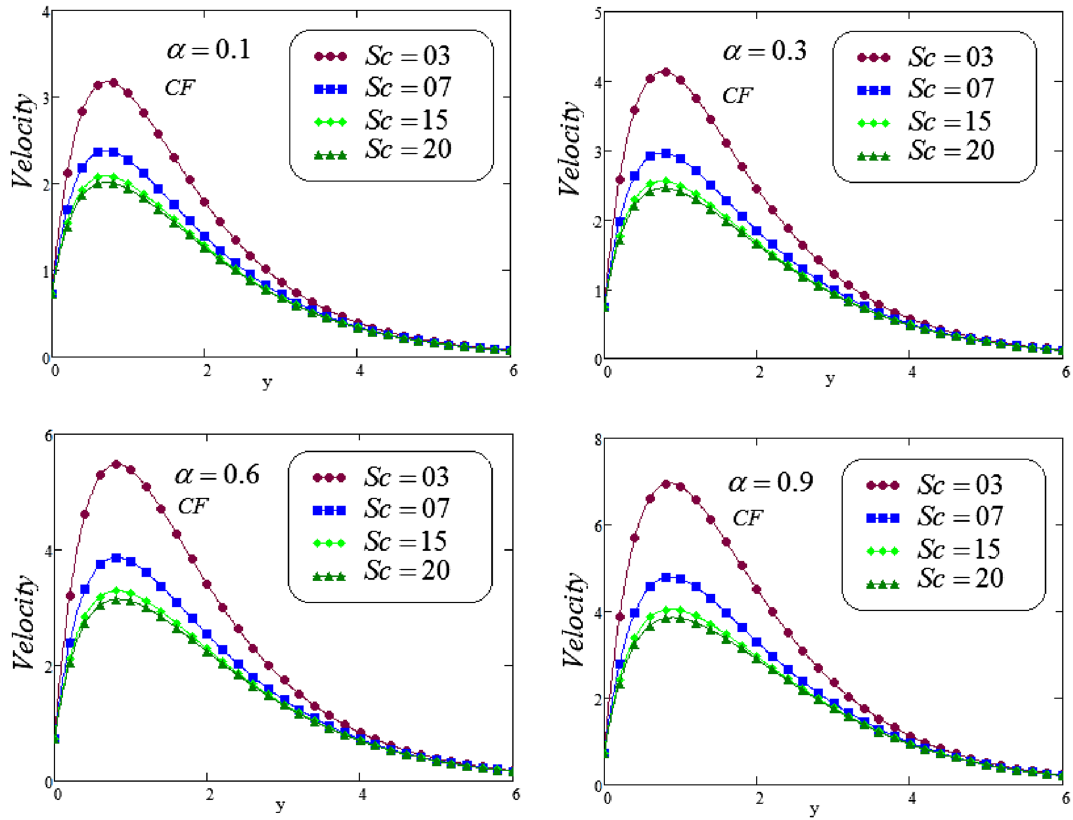
Figure 12. Representation of second grade fluid velocity via CF for distinct values of Sc .